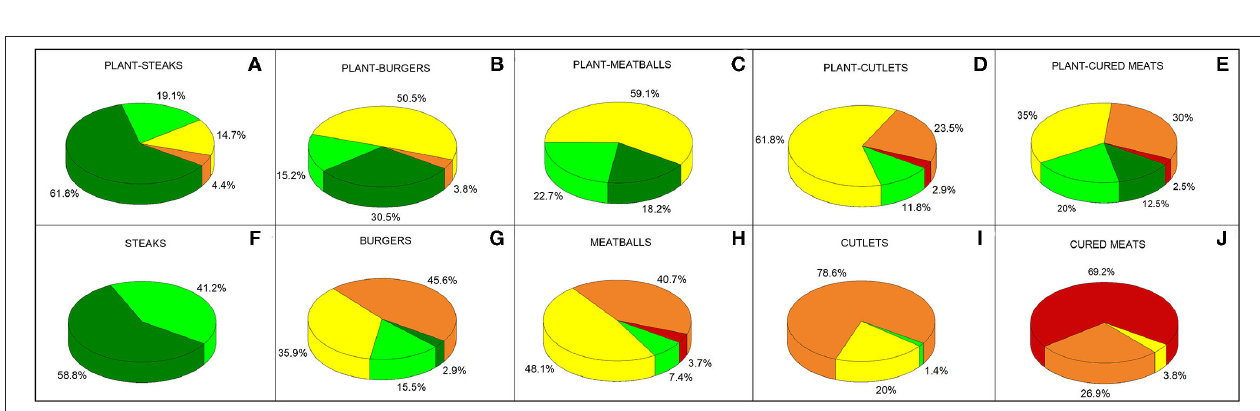
FIGURE 3 | Nutri-score of plant-based analogues (A–E) and meat controls (F–J) . Data are reported as the percentage of products that have a certain score.